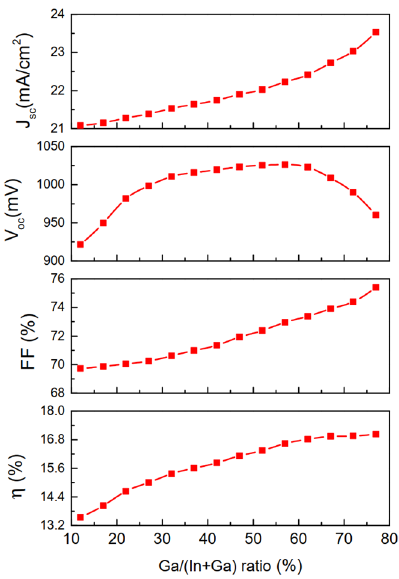
Figure 17. PV characteristics of u-CIGS cells for different Ga/(In+Ga) ratios for sub-layer (CIGS 2).